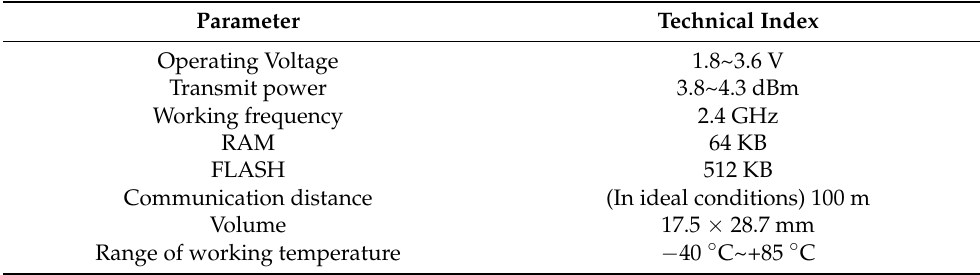
Table 3. E73-2G4M04S1B Bluetooth module performance description.